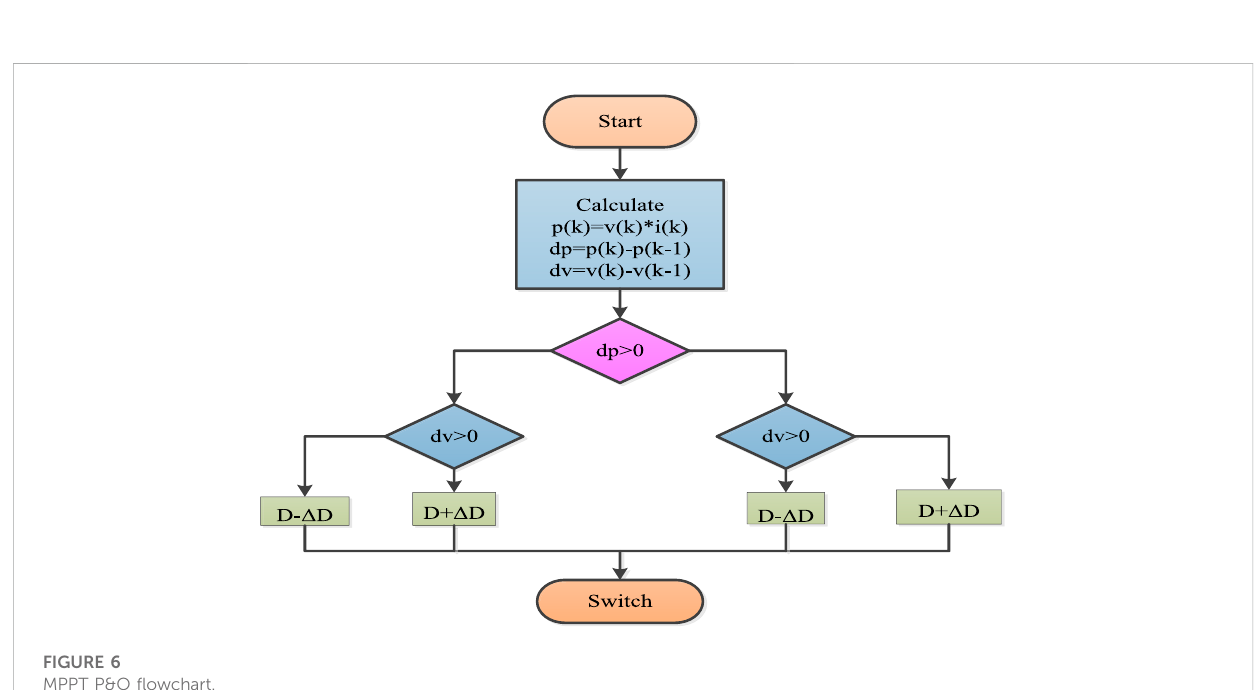
FIGURE 6 MPPT P&O fl